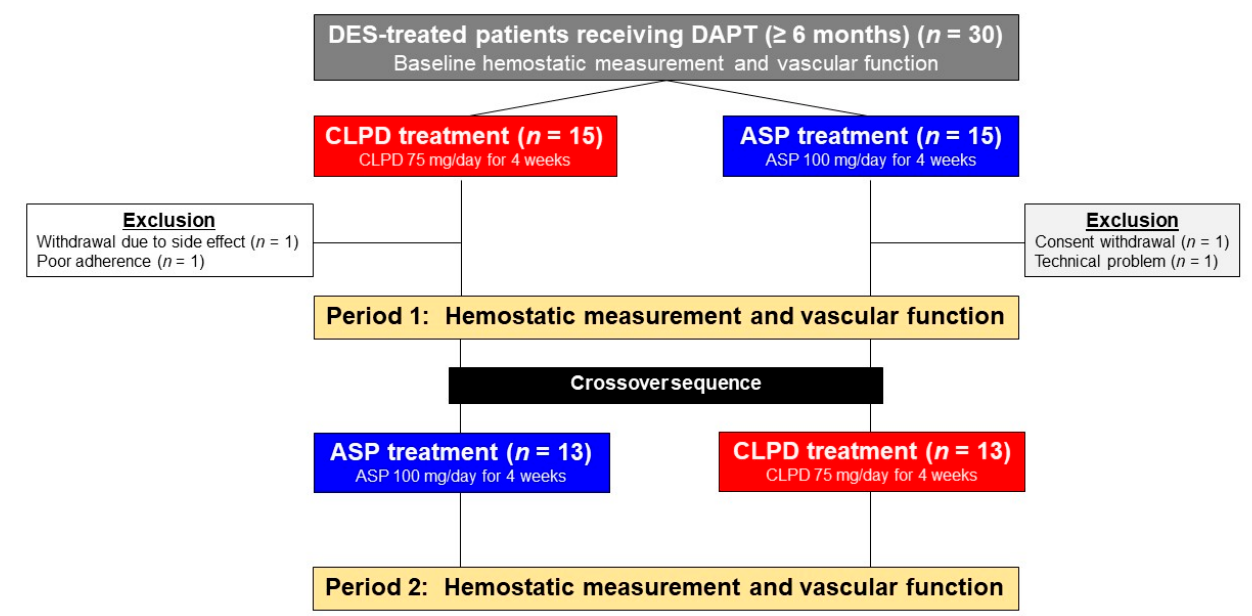
Figure 1. Flow diagram of the study. ASP, aspirin; CLPD, clopidogrel; DAPT, dual antiplatelet therapy; DES, drug-eluting stent.